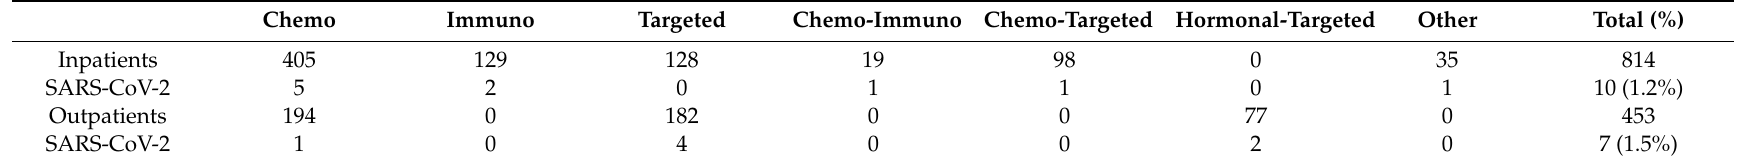
Table 1. Distribution of SARS-CoV-2 infection among cancer patients according to treatment and delivery setting.